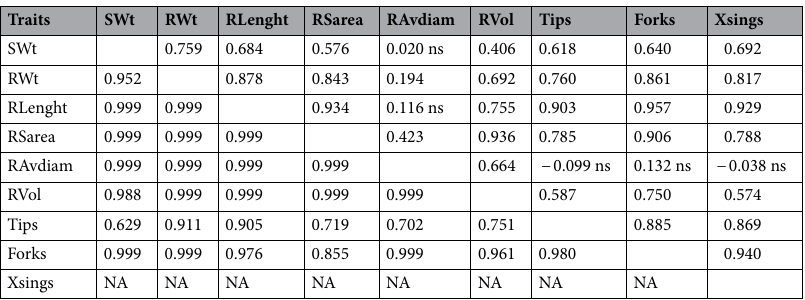
Table 4. The genetic correlations (lower triangle) and phenotypic correlations (upper triangle) between traits across the two N managements. SWt, shoot weight, RWt, root weight, RLength, root length, RSarea, root surface area, RAVdiam, root average diameter, RVol, root volume, Tips, number of root tips, Forks, number of forks, Xsings, number of crossings, ns, not significant at P ≤ 0.05; all others, significant at 0.05 > p < 0.001, NA Not available.